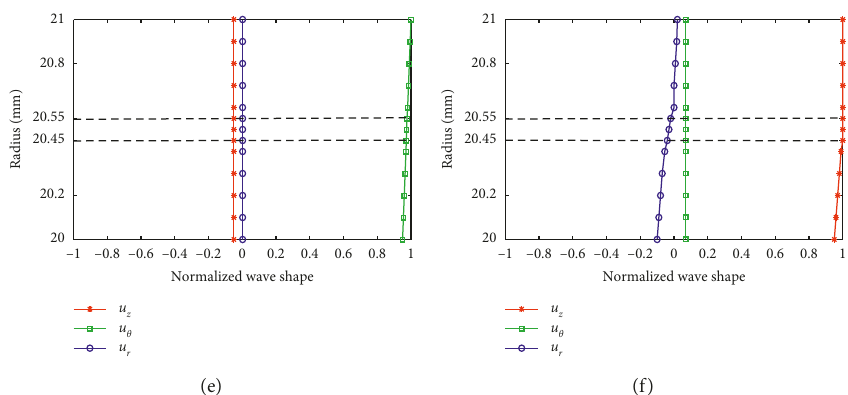
Figure 3: Normalized wave shapes of the guided wave at the frequency 200kHz. (a) L ( 0 , 1 ) . (b) L ( 0 , 2 ) . (c) T ( 0 , 1 ) . (d) F ( 1 , 1 ) . (e) F ( 1 , 2 ) . (f) F ( 1 , 3 ) .